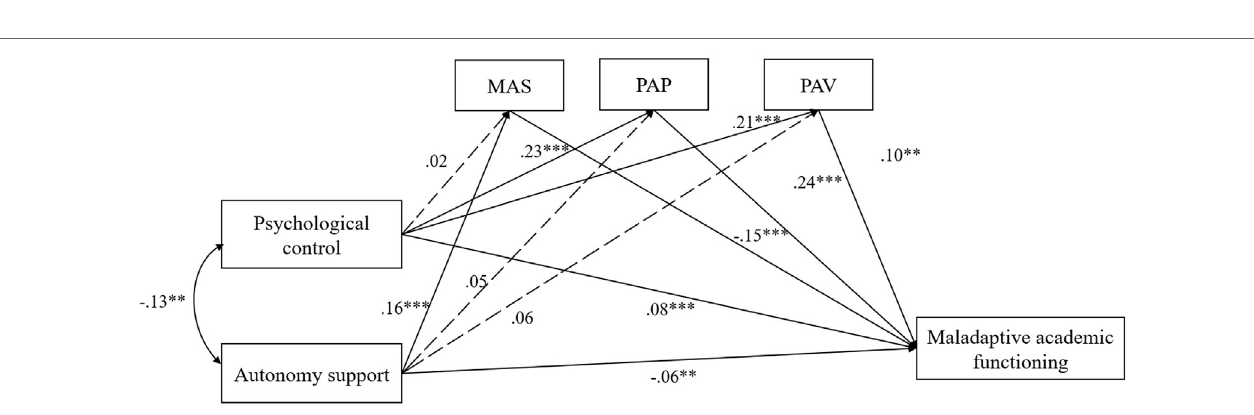
FigUre 1 | Multiple mediation model depicting direct and indirect effects of parental psychological control and autonomy support on students’ maladaptive academic functioning tested in the present study, controlling for gender. Abbreviations: MAS, mastery goal orientation; PAP, performance-approach goal orientation; PAV, performance-avoidance goal